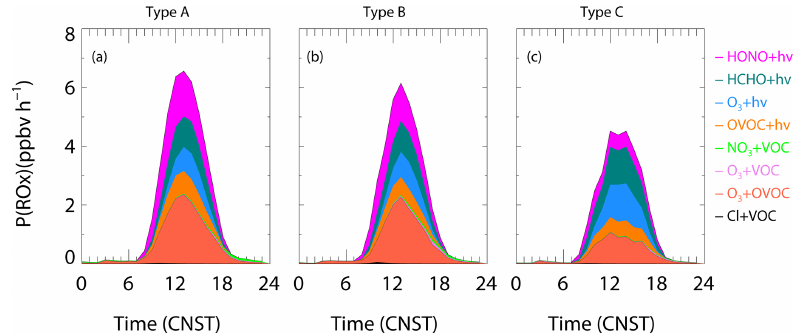
Figure 9. The diurnal cycle and distribution of RO x production rate in the three types of air masses.